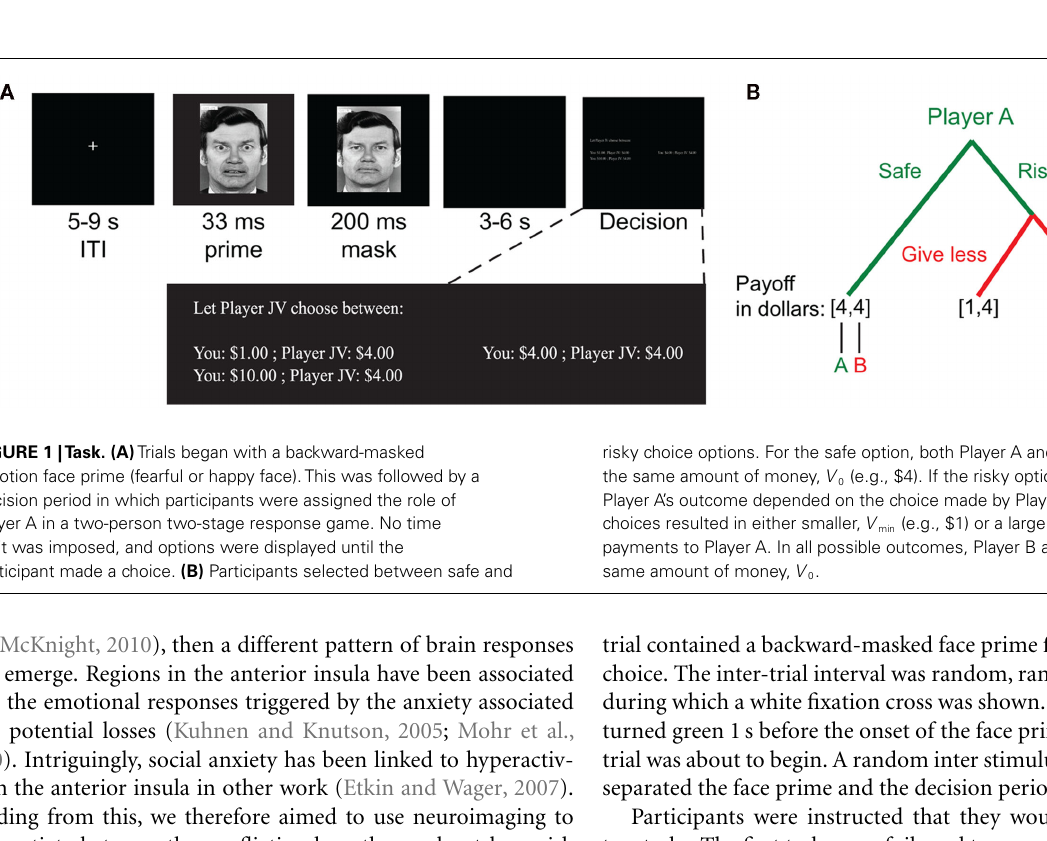
risky choice options. For the safe option, both Player A and Player B received the same amount of money, V 0 (e.g., $4). If the risky option was selected, Player A’s outcome depended on the choice made by Player B. Player B choices resulted in either smaller, V min (e.g., $1) or a larger, V max (e.g., $10), payments to Player A. In all possible outcomes, Player B always received the same amount of money, V 0